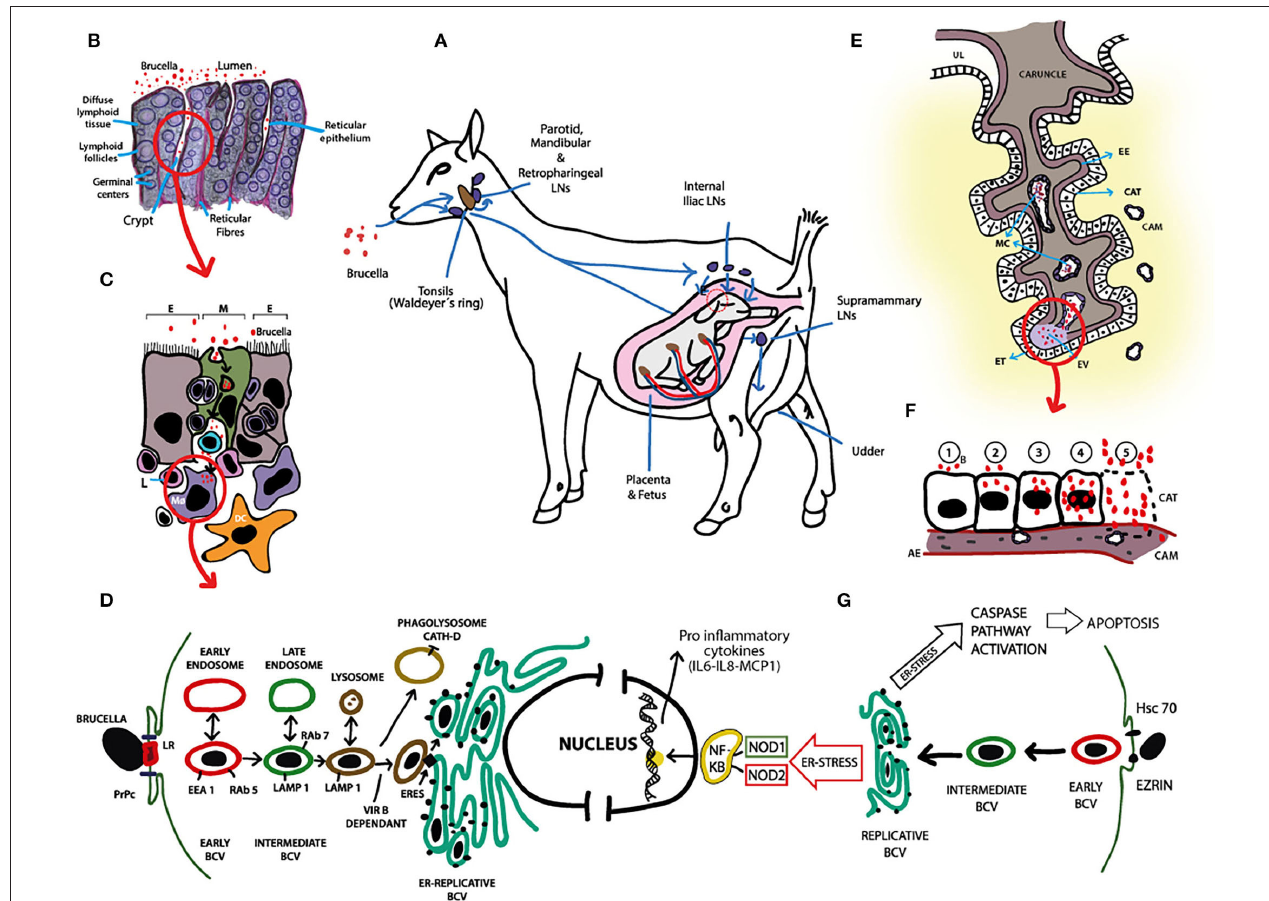
FIGURE 2 | Pathogenesis of B. melitensis infection in small ruminants. (A) B. melitensis infects small ruminants mainly via the alimentary tract. Once in the oral cavity, B. melitensis enters through the mucosa or the oro- and nasopharyngeal tonsils (Waldeyer’s ring) and colonizes, proliferates and persists in the lymph nodes (LNs) of the head (i.e., mandibular, parotid, and lateral and medial retropharyngeal LNs). Failure to eliminate B. melitensis on this primary line of defense results in escape of the bacteria through the efferent lymphatic vessels to the distal LN or via blood to the general circulation. In pregnant females, B. melitensis colonizes placenta and induces abortion or stillbirth. Brucella melitensis also has affinity for lactating udder. Significant numbers of B. melitensis are excreted in vaginal discharges, aborted fetus, placenta and milk. (B) Illustration of histological structure of tonsils. B. melitensis is first seen in the lumen of the oral cavity. Subsequently, B. melitensis colonizes the crypts and invade through reticular epithelium. (C) Reticular epithelium is composed of scattered M cells (M; green), lymphoid cells and the epithelial cell types (E). M cells endocytose B. melitensis from the lumen, after which transcytosis and basolateral release occurs. Immediately, the agent is up taken by